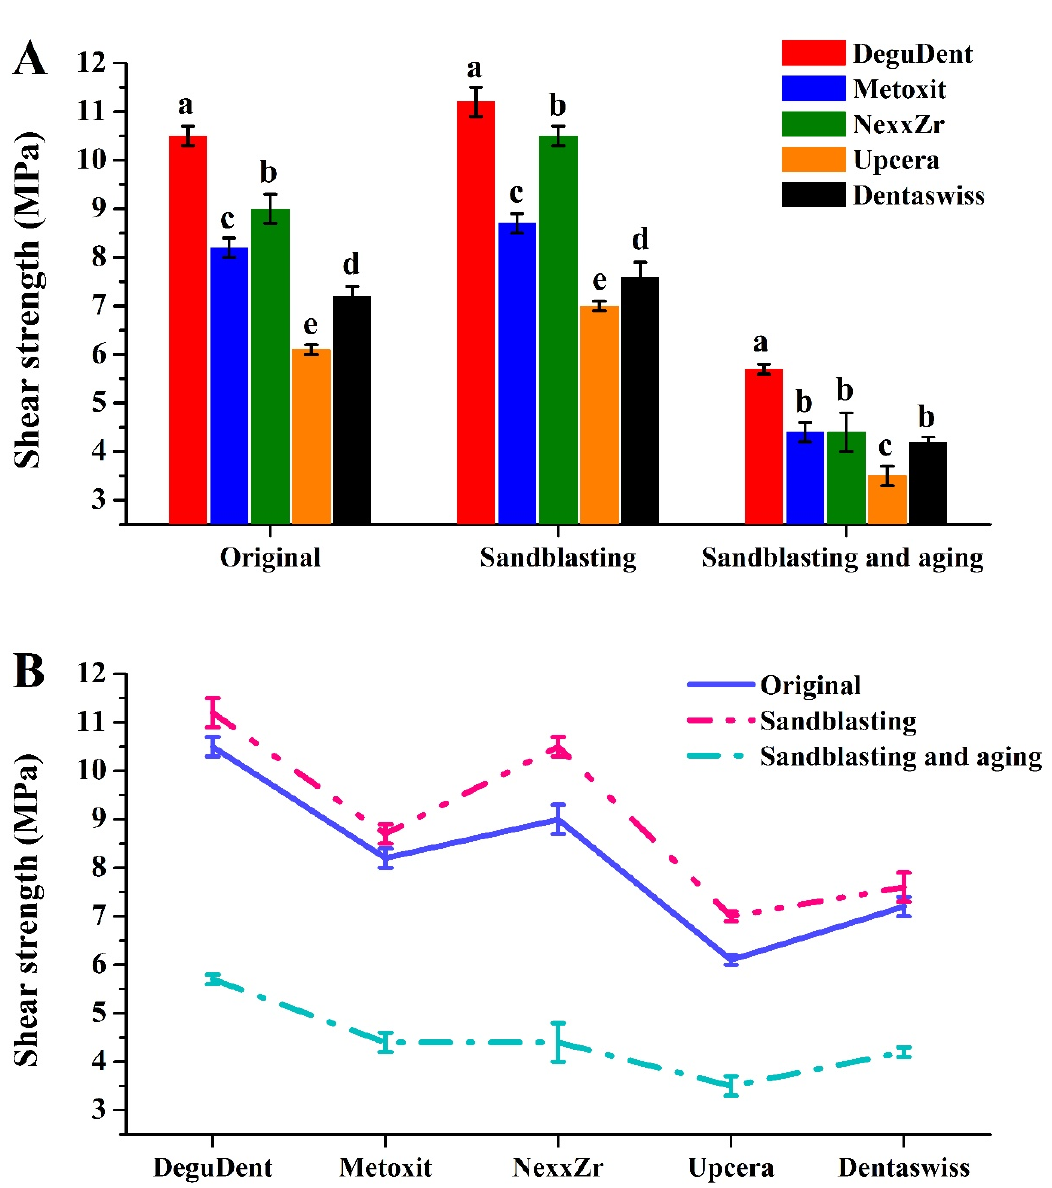
Figure 8. Comparison of bond strength between different zirconia samples and teeth after the aging test: ( A ) The effect of various surface treatments on different brands of zirconia; ( B ) The changing trend of the shear strength of different surface treatments of a single brand of zirconia. Means with different letters were significantly different ( p < 0.05, mean ± SD, n = 4).